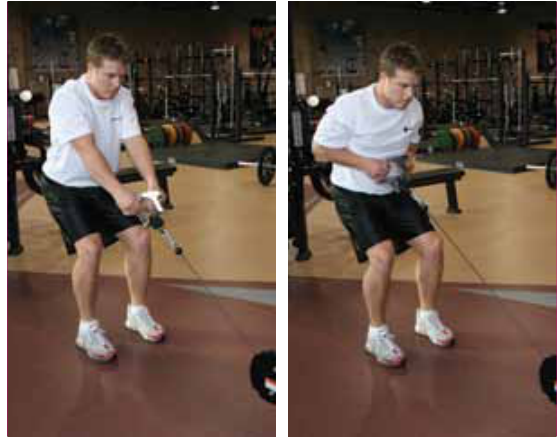
Figure 4-32. Start Position Figure 4-33. Finish Position